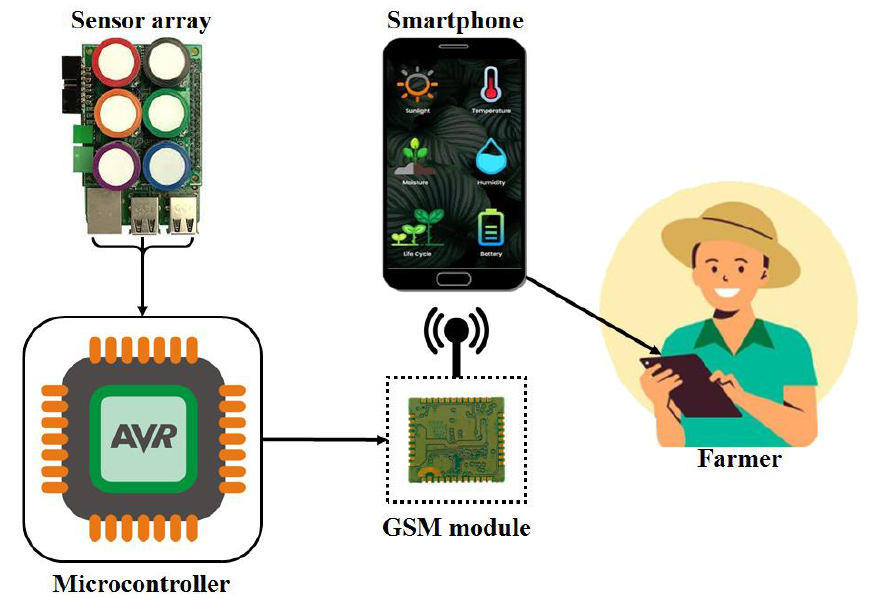
Figure 1. Overview of irrigation systems based on smart sensors.